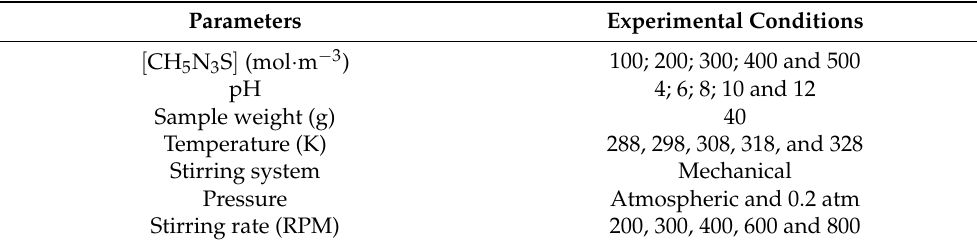
Table 2. Experimental conditions used for the study of leaching of MW.